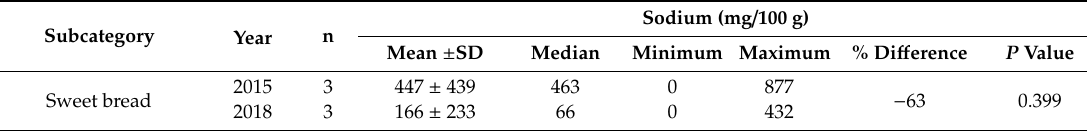
Table 1. Sodium content in packaged food by subcategories with national reduction targets, Costa Rica